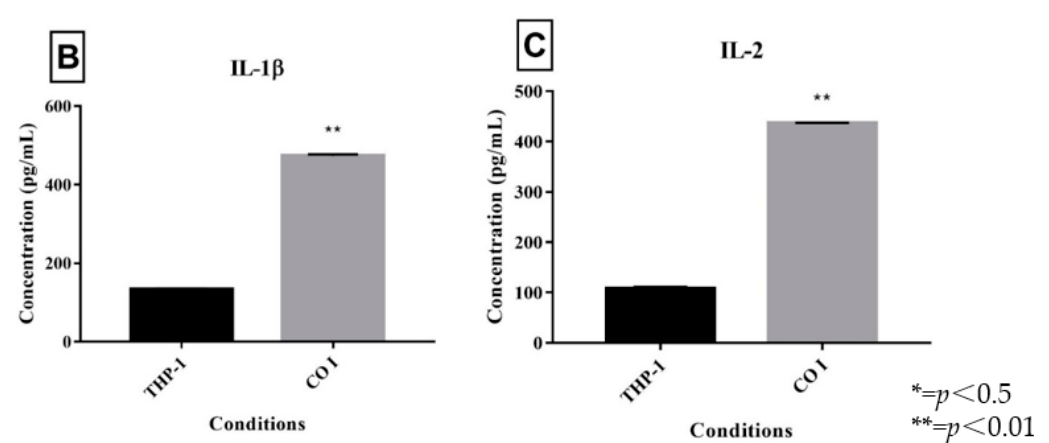
Figure 2. Quantification of IL-6 after different incubation times ( A ) and IL-1 β ( B ) and IL-2 ( C ) in co-cultures of inactivated germinated Trichophyton rubrum microconidia (CGI) with human THP-1 macrophages compared to control (THP-1) after 24 h.